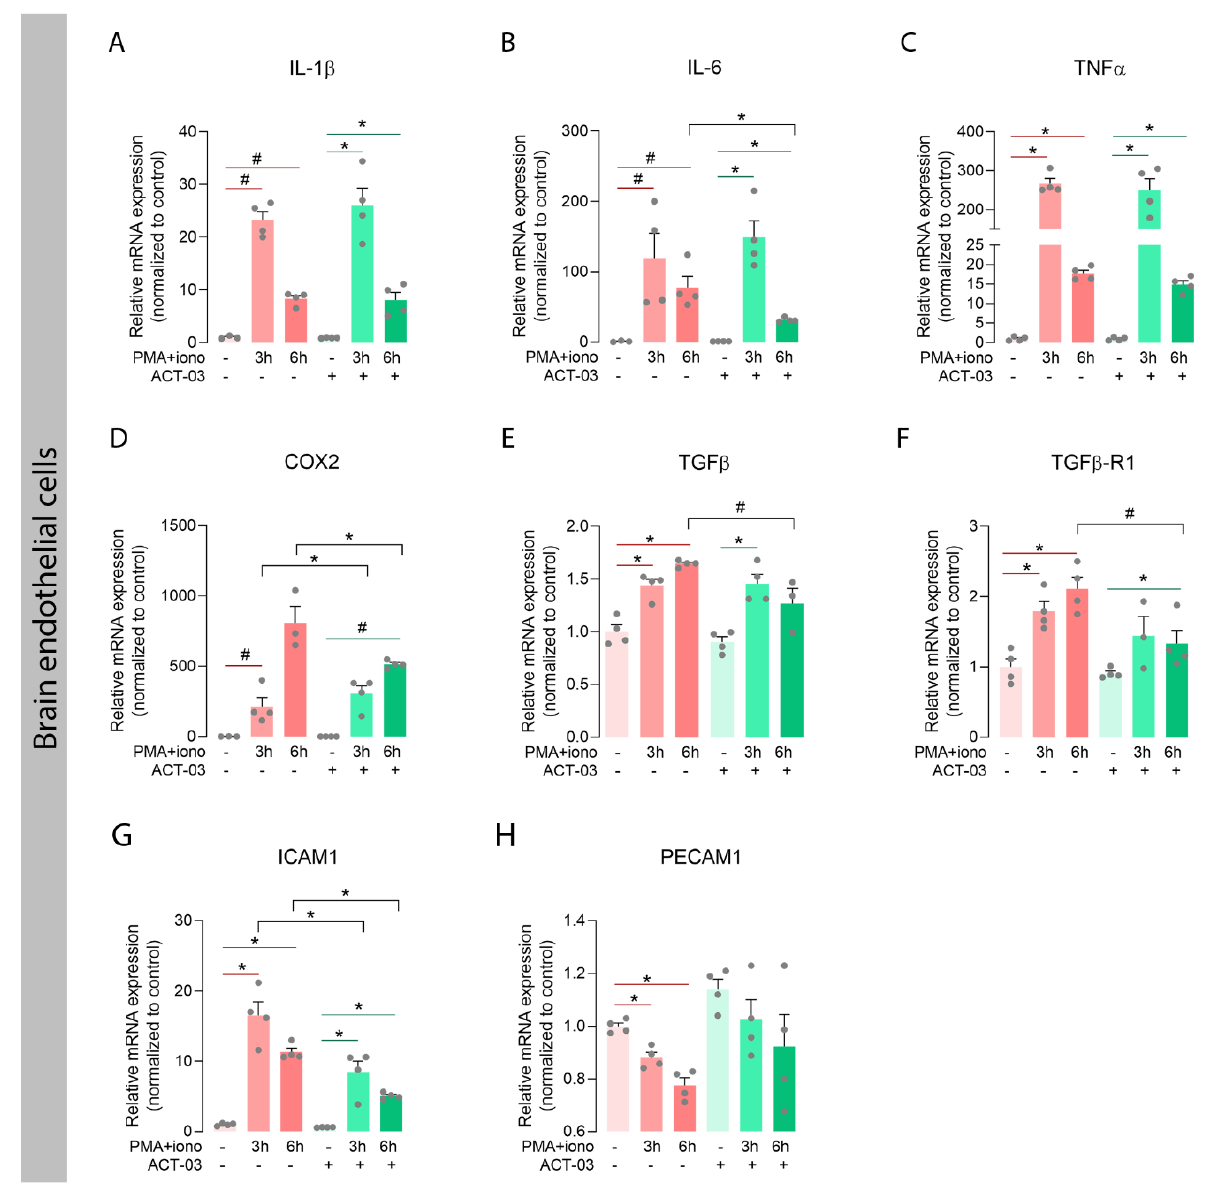
Figure 5. Attenuation of inflammatory factors by ACT-03 in brain endothelial cell cultures. ( A – H ) PMA + iono stimulation of the human brain endothelial cell line hCMEC/D3 ( n = 4) induced higher expression of TNF α , TGF β , TGF β -R1, and ICAM1 ( p < 0.05), and trends towards higher expression of IL-1 β , IL-6, and COX2 ( p = 0.0571). ACT-03 treatment reduced the PMA + iono-induced expression of IL-6, COX2, and ICAM1 ( p < 0.05) and resulted in a trend towards less expression of TGF β and TGF β -R1 ( p = 0.0571). Bar graphs display mean + SEM, with individual values as dots; # , p = 0.0571; *, p < 0.05. Within treatment comparisons indicated with red/green lines. Between treatment comparisons indicated with hooked black lines.